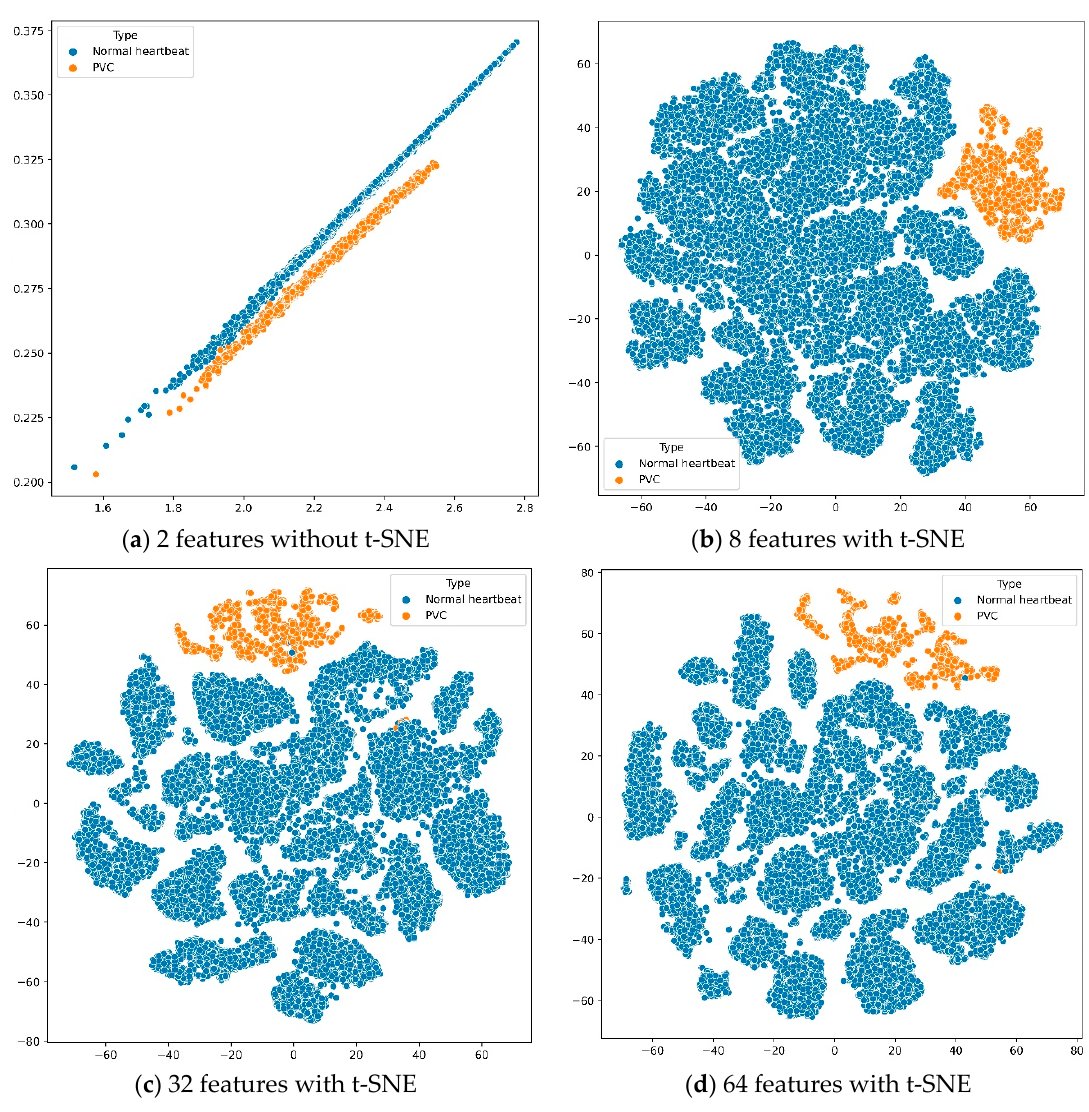
Figure 6. Visualizing the features of training data.